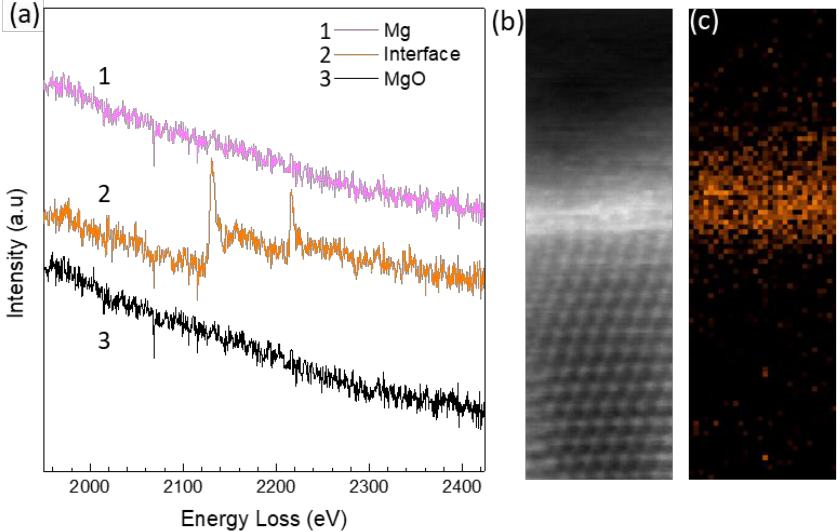
Figure 27. Yttrium segregation at Mg/(1 1 1)MgO interface [28]. ( a ) STEM/EELS spectra acquired from areas of Mg (curve 1), MgO/Mg interface (curve 2) and MgO (curve 3) where yttrium edge loss is clearly seen from curve 2; ( b ) STEM HAADF image along [0 1 1]MgO direction during EELS acquisition; and ( c ) corresponding EELS elemental map of yttrium, showing segregation of yttrium at the interface.